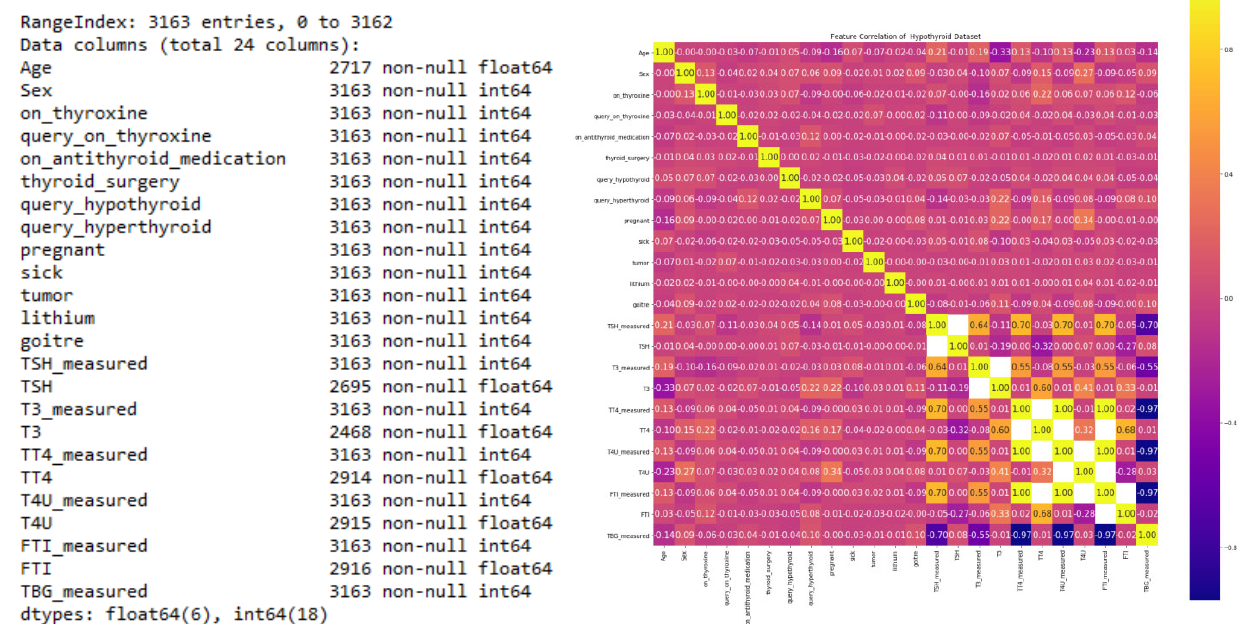
Figure 5. Statistical information and correlation matrix of the dataset.